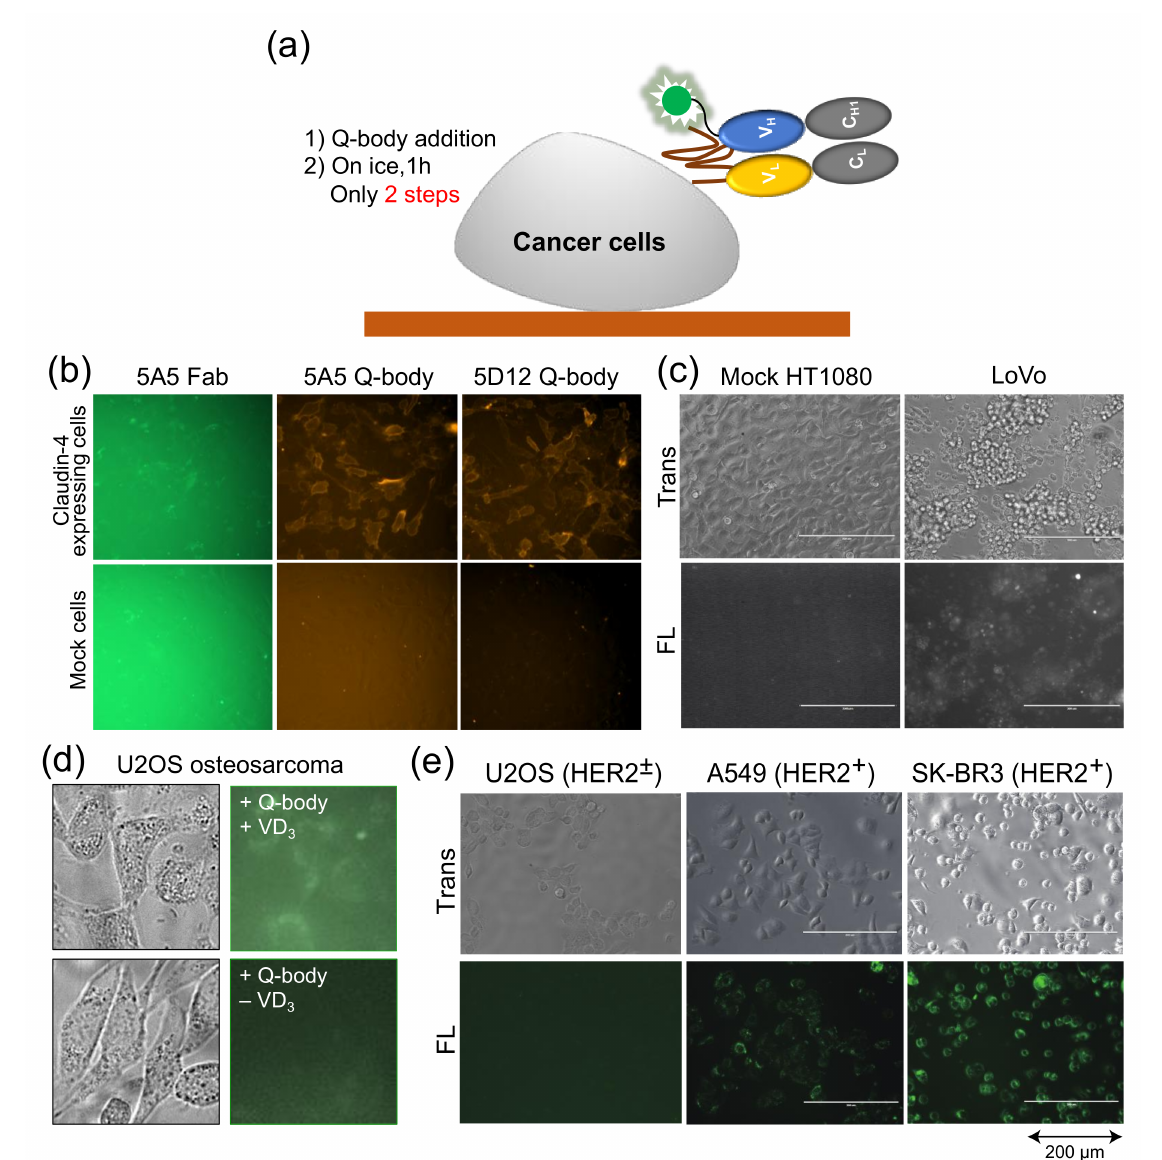
Figure 4. Quenchbodies for imaging cells. ( a ) Bioimaging using Quenchbody; ( b , c ) Claudin-4 expressed on the membrane of transfected HT1080 cells ( b ) and LoVo colon cancer cells ( c ). Reprinted with permission from [38]. Copyright 2017 American Chemical Society. ( d ) Bone Gla protein produced by vitamin D3-induced U2OS osteosarcoma; ( e ) HER2 on cancer cells with different HER2 expression levels. Reprinted with permission from